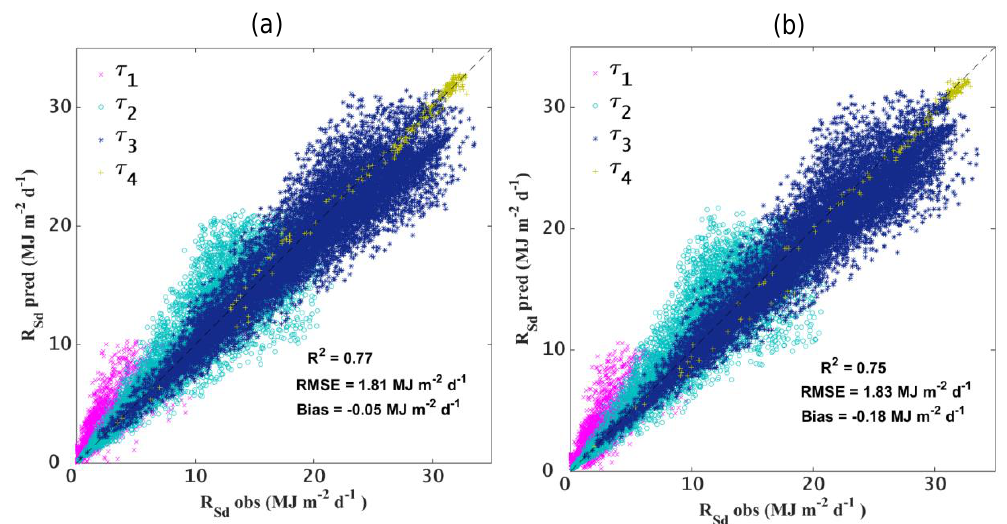
Figure 5. Scatter plots showing R Sd_pred vs. R Sd_obs for different levels of daily atmospheric transmissivity classes ( τ) from (a) 11:00 to (b) 13:30LT upscaling. Here τ 1 – τ 4 represent daily atmospheric transmissivity of four different classes, 0.25 ≥ τ ≥ 0, 0.50 ≥ τ ≥ 0.25, 0.75 ≥ τ ≥ 0.50, and 1 ≥ τ ≥ 0.75, respectively, with τ 1 signifying a high degree of cloudiness (or overcast skies) whereas τ 4 indicates clear skies.